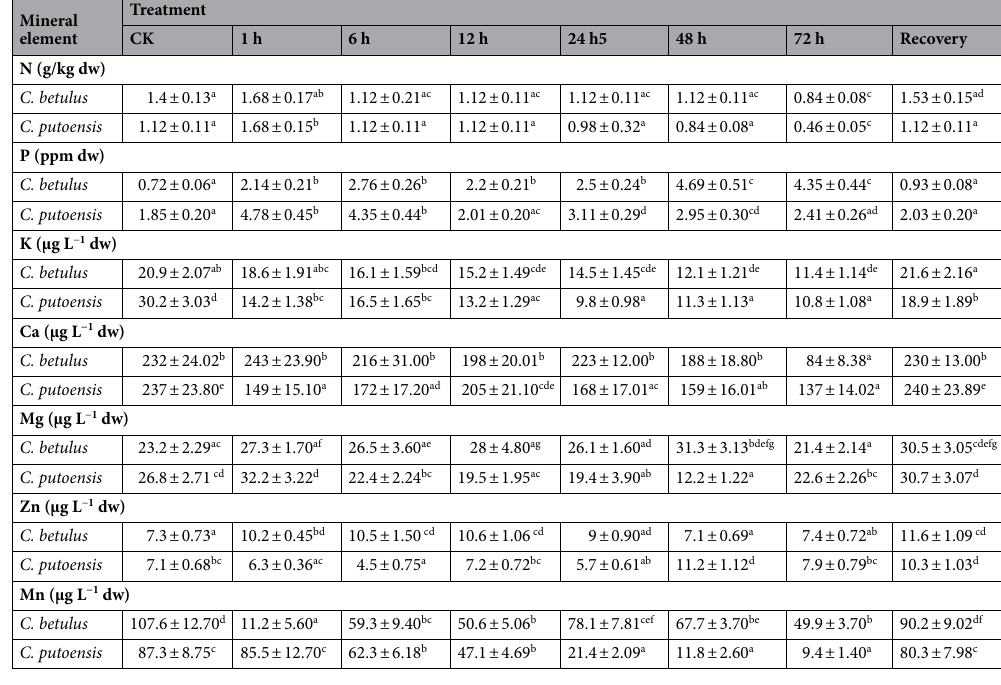
Table 2. Changes in the mineral element contents of C. betulus and C. putoensis under NO 2 stress and after self